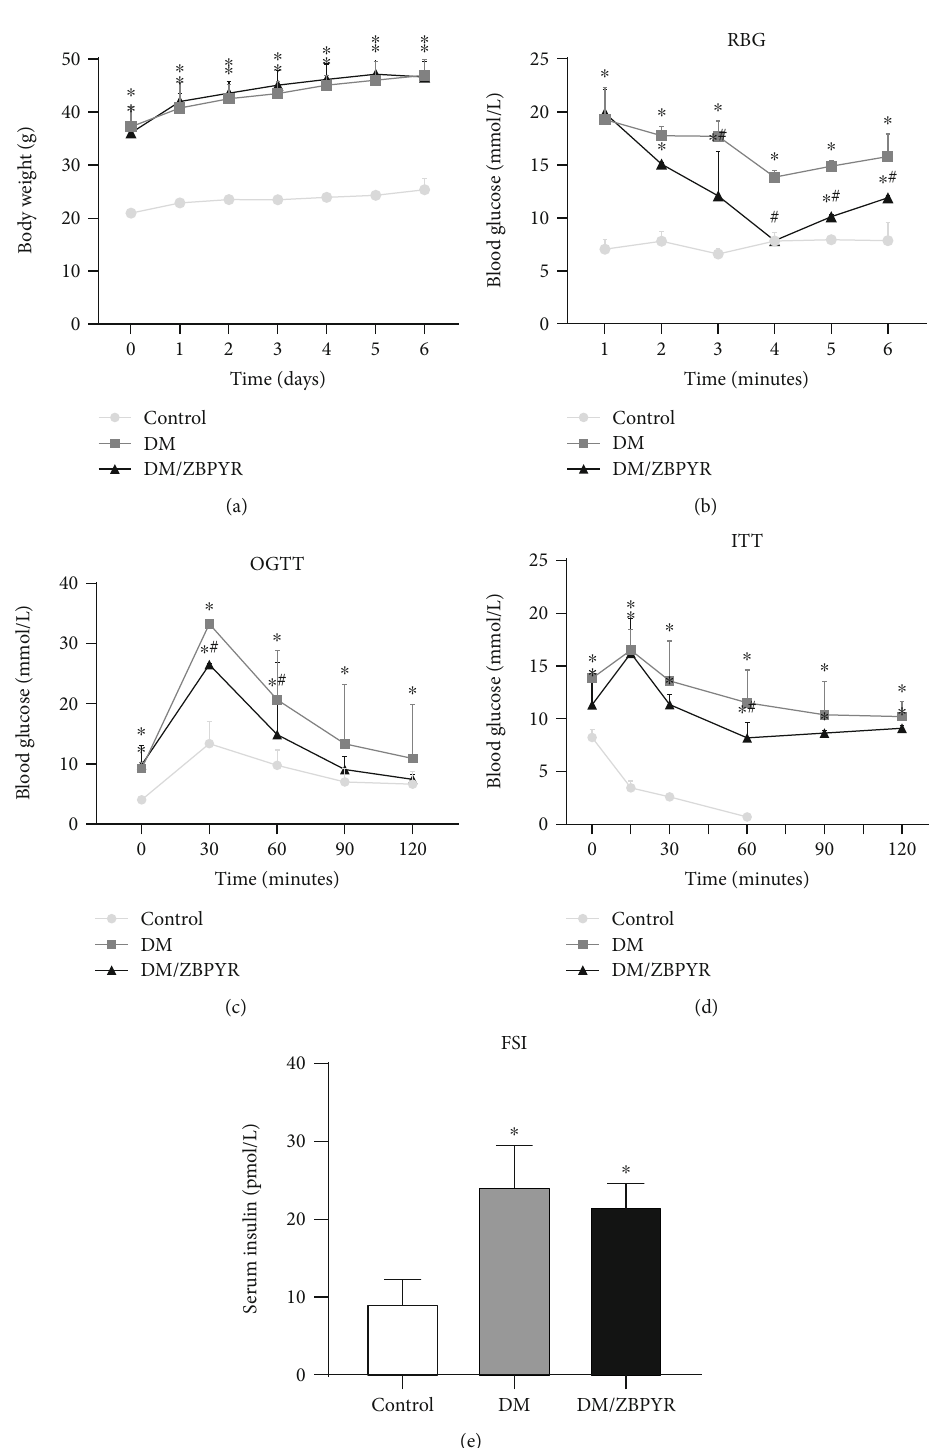
Figure 1: The antidiabetic e ff ects of ZBPYR on db/db mice. (a) Body weight was recorded weekly. (b) RBG level was measured every week in the three groups during ZBPYR administration. (c – e) OGTT, ITT and FSI level were measured at the end of treating period. Values are means ± S : D : from 4 mice in each group. ∗ p < 0 : 05 compared to control; # p < 0 : 05 compared to